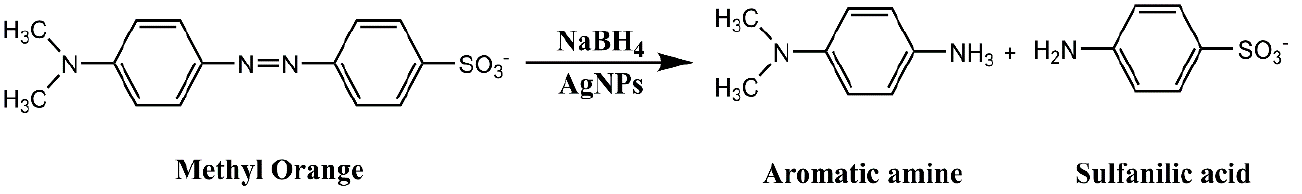
Figure 10. Schematic representation of reduction of Methyl Orange (MO).